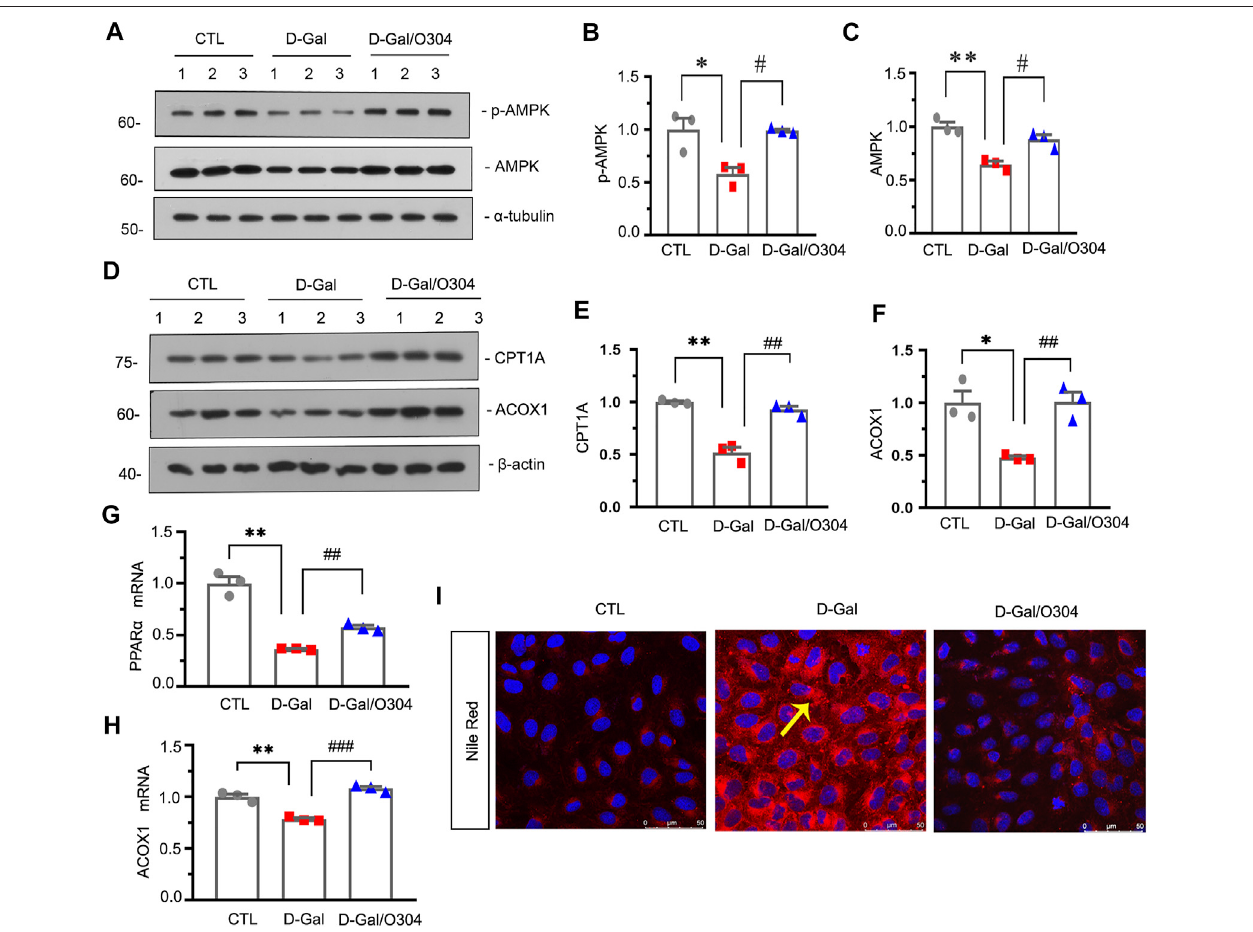
FIGURE 7 | O304 could activate AMPK and promote fatty acid metabolism in vitro . (A – C) Representative western blot showing the expression of p-AMPK and AMPK in different groups. HKC-8 cells were stimulated by D-Gal (10 mg/ml) for 60 h with or without O304 (50 nM). * p < 0.05, ** p < 0.01 versus control (Ctrl) cells; # p < 0.05 versus D-Gal-treated group alone ( n = 3). (D – F) Representative western blot and quantitative data showing the expression of CPT1A and ACOX1. * p < 0.05, ** p < 0.01 versus control group; ## p < 0.01 versus D-Gal-treated group alone ( n = 3). (G,H) Graphical representations show the relative abundance of PPAR α and ACOX1 mRNA in different groups. ** p < 0.01 versus control group; ## p < 0.01, ### p < 0.001 versus D-Gal-treated group alone ( n = 3). (I) Representative micrographs showing the formation of fat in HKC-8 cells by Nile red staining in different groups. Arrows indicate positive staining of fatty